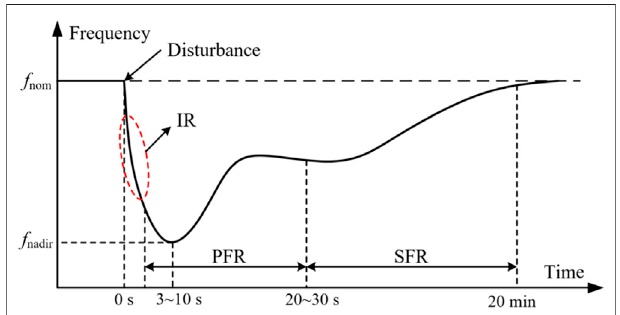
FIGURE 1 | Frequency regulation strategies of asynchronous generator (Tto, 2010).